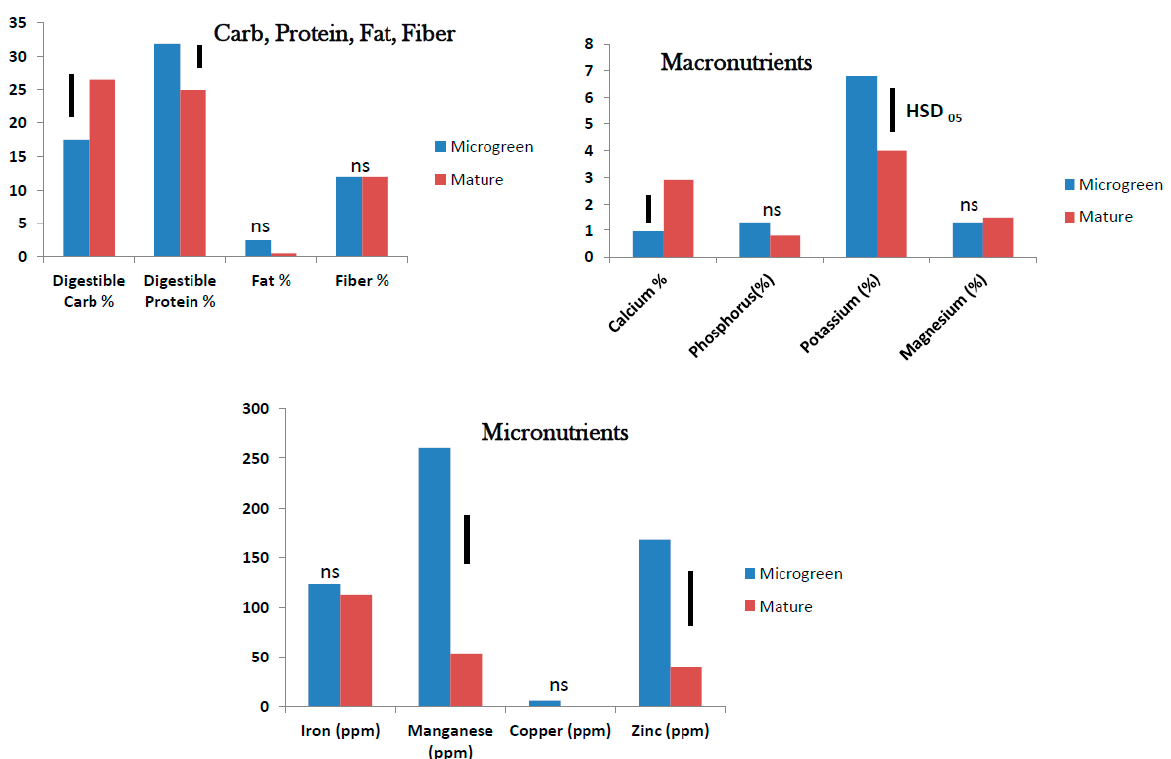
Figure 6. Nutrient status compared on dry weight basis between tropical spinach micro/baby-green (average of 10–20-day old seedlings) and mature plant (average of 5- and 7-week-old plants) (ns = no significant difference; bars show Tukey’s HSD at α = 0.05).